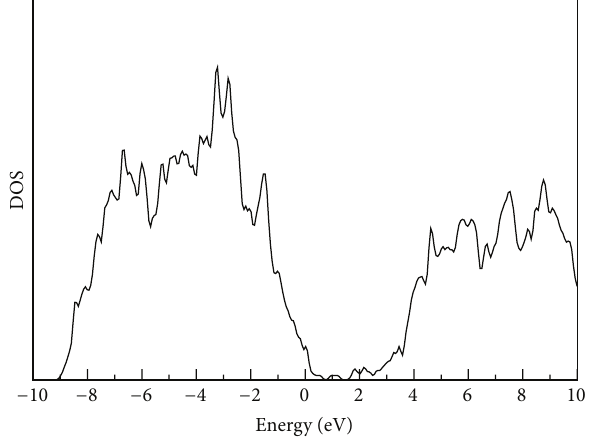
Figure 3: Total density of state of GaN/Al 2 O 3 N-terminated interface. The level Fermi is located in zero.